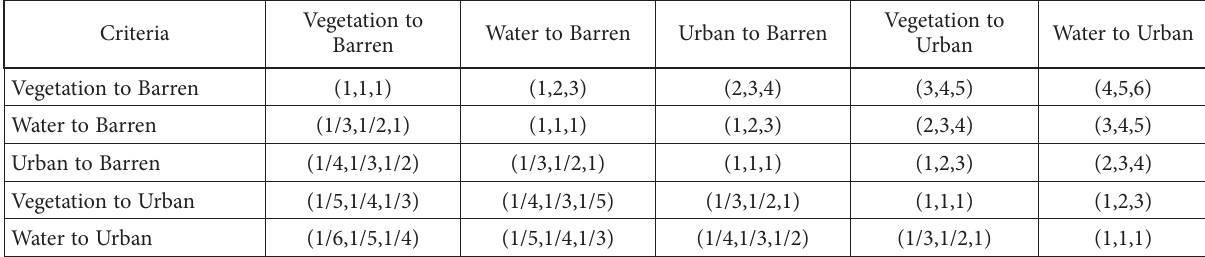
Vegetation to Water to Urban Urban